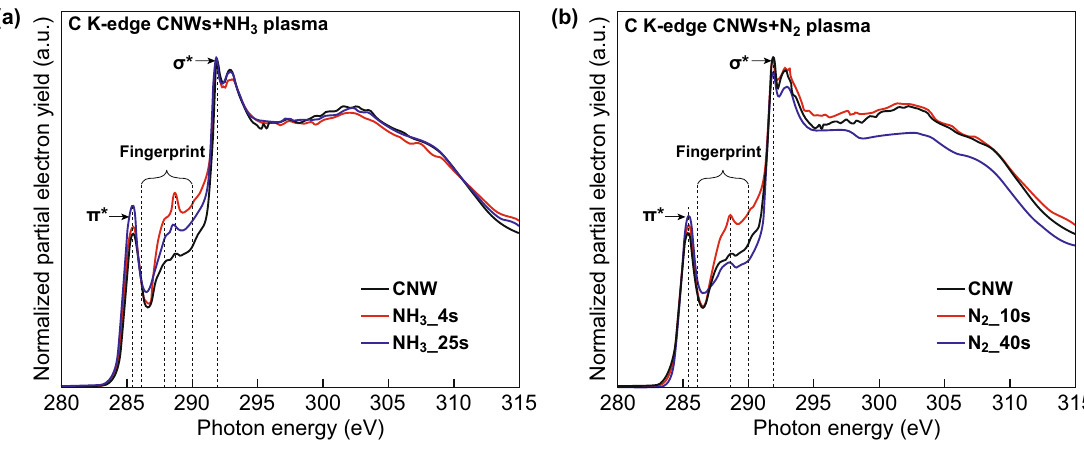
Fig. 5 C K-edge spectra of the CNWs and N-CNWs: a nontreated, 4 s and 25 s NH 3 plasma-treated CNWs, and b the nontreated, 10 s and 40 s N 2 plasma-treated